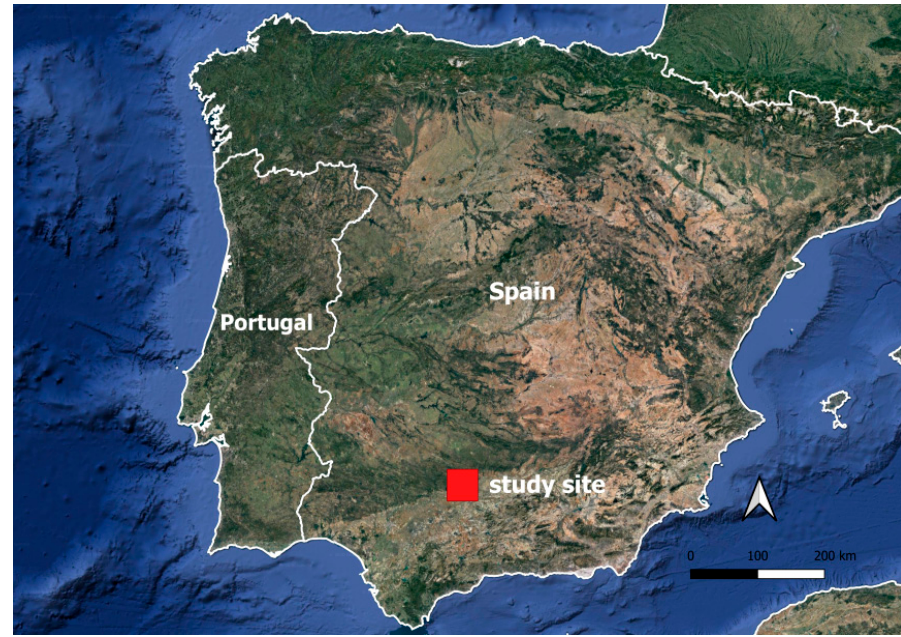
Figure 1. Location of study site.